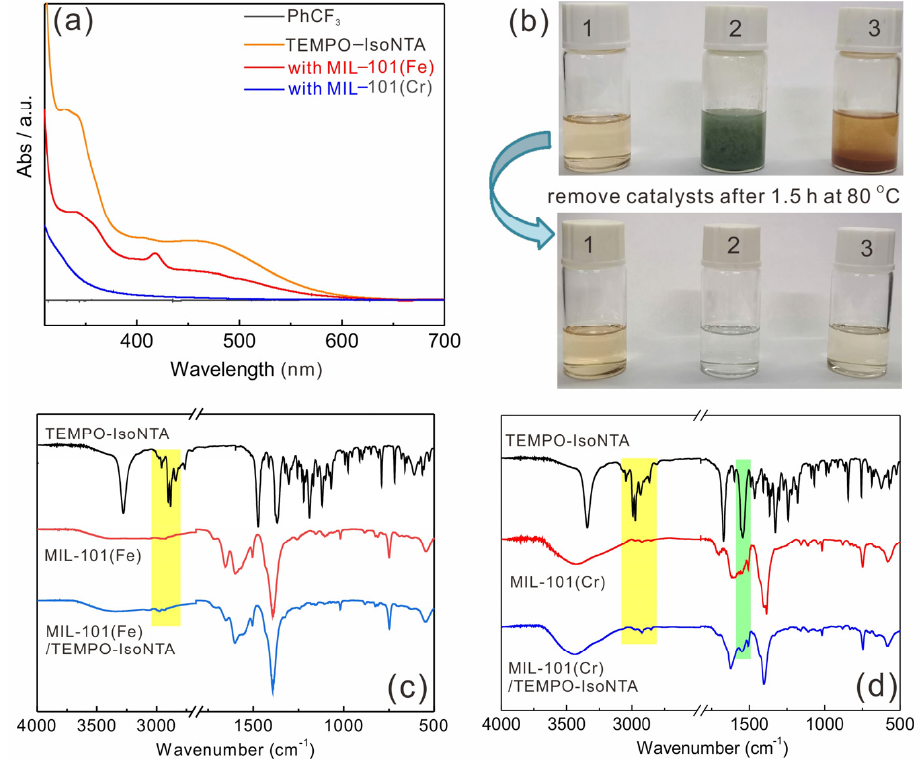
Figure 3. ( a ) UV–Vis adsorption spectra of TEMPO-IsoNTA with MIL-101(Fe) or MIL-101(Cr); ( b ) photographs of the color changes of TEMPO-IsoNTA solution (1), before (up) and after (down) adsorption with MIL-101(Cr) (2) and MIL-101(Fe) (3); ( c ) FT-IR spectra of TEMPO-IsoNTA, MIL- 101(Fe) and MIL-101(Fe)/TEMPO-IsoNTA; ( d ) FT-IR spectra of TEMPO-IsoNTA, MIL-101(Cr) and MIL-101(Cr)/TEMPO-IsoNTA.